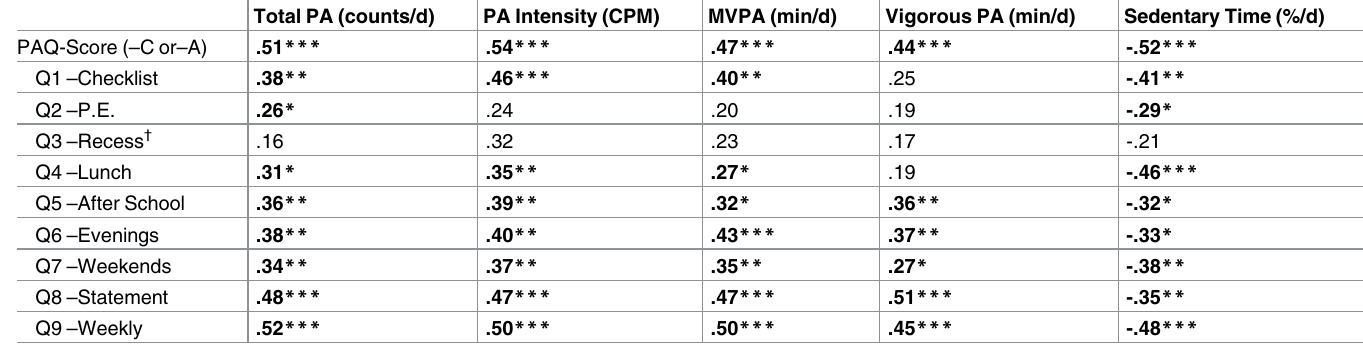
Table 2. Spearman rank correlations between accelerometry-derived physical activity metrics and PAQ-score items ( n =